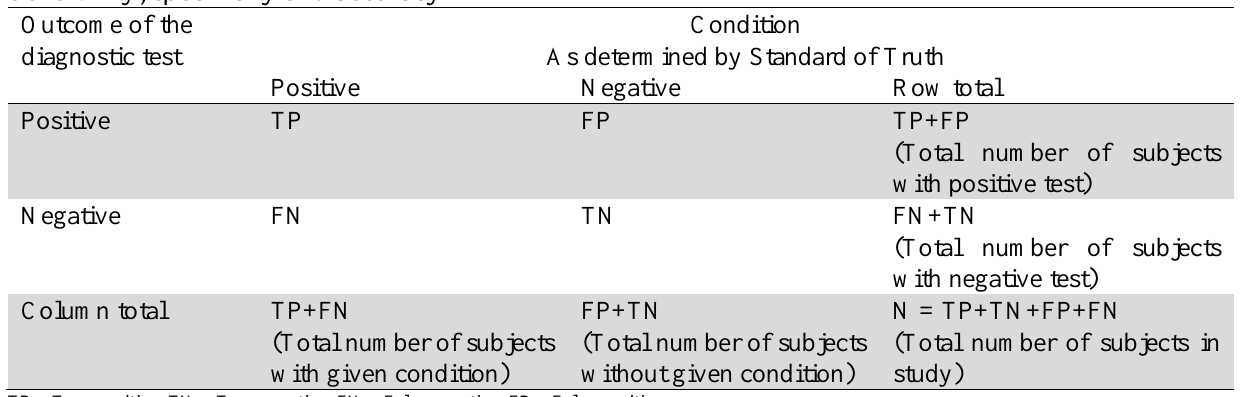
Sensitivity, specificity and accuracy Outcome of the Condition diagnostic test As determined by Standard of Truth Positive Negative Row total Positive TP FP TP+FP (Total number of subjects with positive test) Negative FN TN FN+TN (Total number of subjects with negative test) Column total TP+FN (Total number of